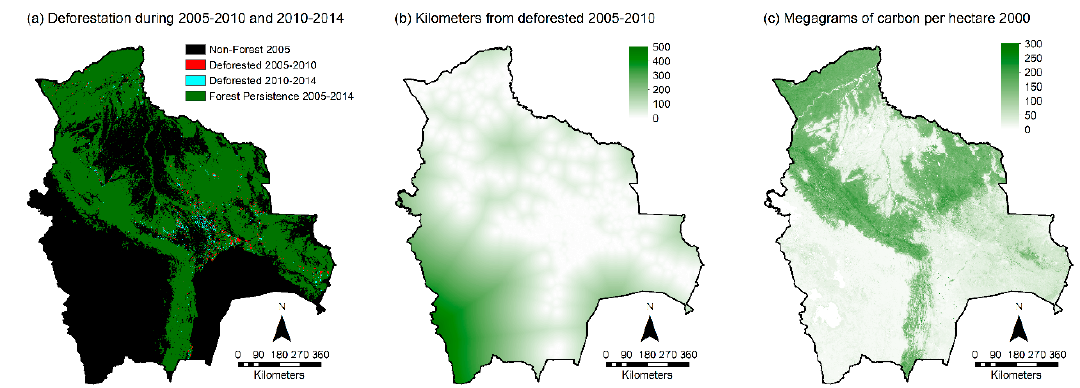
Figure 2. Maps of ( a ) deforestation; ( b ) distance from calibration deforestation; and ( c ) carbon density.